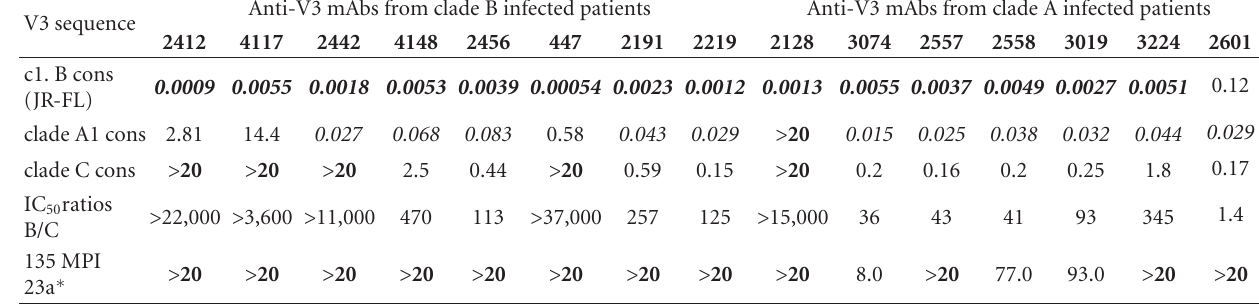
Table 2: IC 50 s (ug/mL) of 15 di ff erent antibodies (columns) derived from subtype B and subtype A infected patients neutralizing the infectivity of psVs containing the subtype C and B V3 sequences in the SF162 Env backbone. For comparison, the IC 50 values for a non- V3 Ab (b12) are as follows: clade B cons. (JR-FL) = 0.009 ug/mL; clade C cons. = 0.02 ug/mL, all others untested; which does not show as dramatic a di ff erence in neutralization between the two psVs. 135 MPL23a is a subtype C primary isolate and is included as an example of IC 50 values in non-neutralization-sensitive (“masked”) backgrounds. IC 50 values are font-type coded as follows: bold > 0.1ug/mL; italic < 0.1ug/mL; bold/italic < 0.01